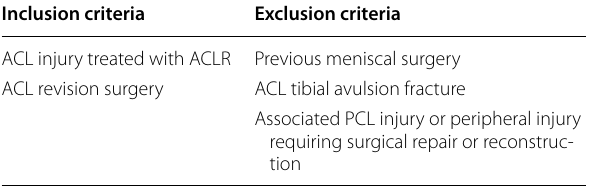
Table 2 Prevalence of LMRA in primary reconstructions